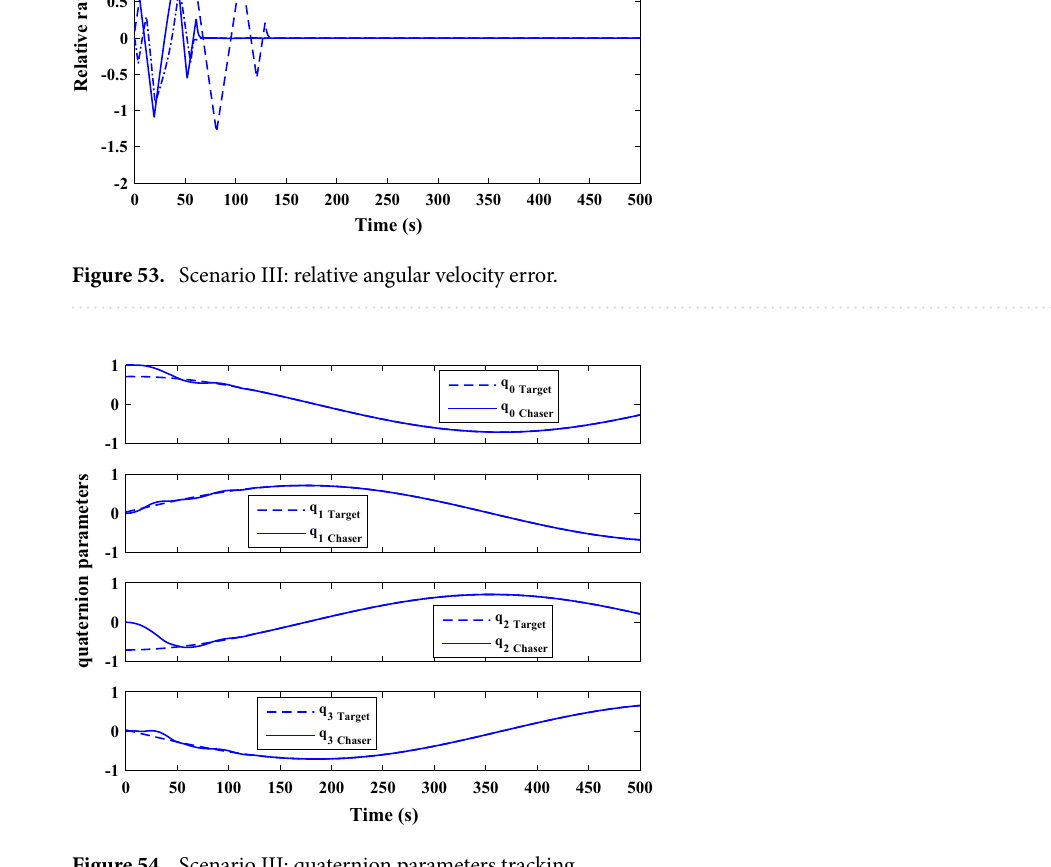
Figure 54. Scenario III: quaternion parameters